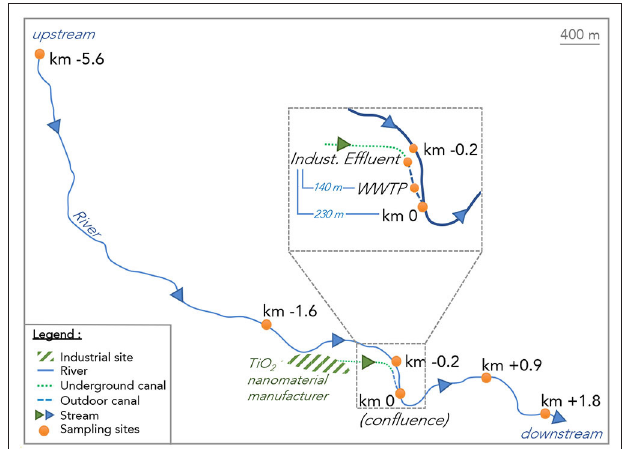
FIGURE 1 | Map of river sampling sites near TiO 2 nanomaterial manufacturing plant, with distances along the river given relative to the confluence of the industrial drainage canal and the river at km